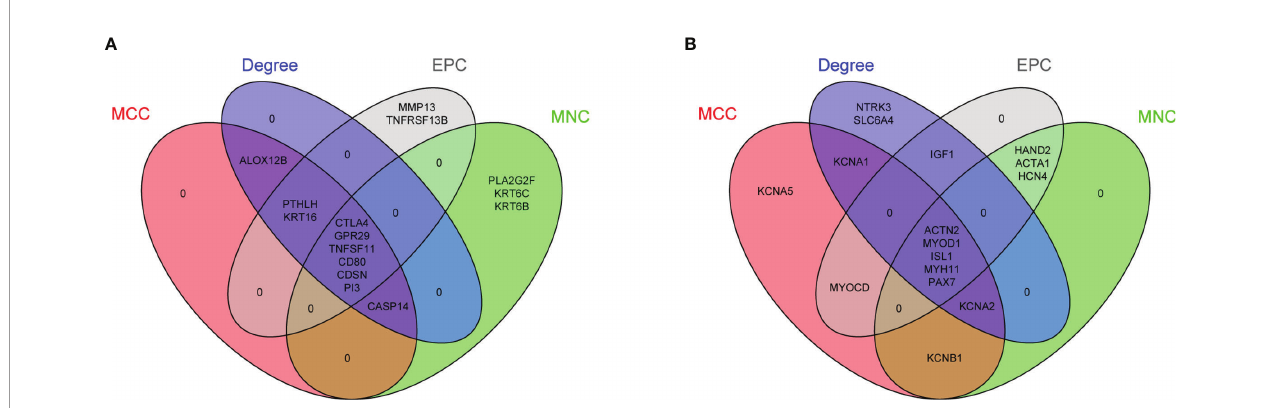
FIGURE 4 | Identi fi cation of potential hub genes from PPI networks of MeDEGs. (A) Venn diagram of highly connected genes identi fi ed by four calculation methods from PPI network of upregulated and hypomethylated genes. Six overlapping genes were identi fi ed in the intersection of all lists. (B) Venn diagram of highly connected genes identi fi ed by four calculation methods from PPI network of downregulated and hypermethylated genes. Five overlapping genes were identi fi ed in the intersection of all lists. List of calculation methods: MCC (red), MNC (green), Degree (blue), and EPC